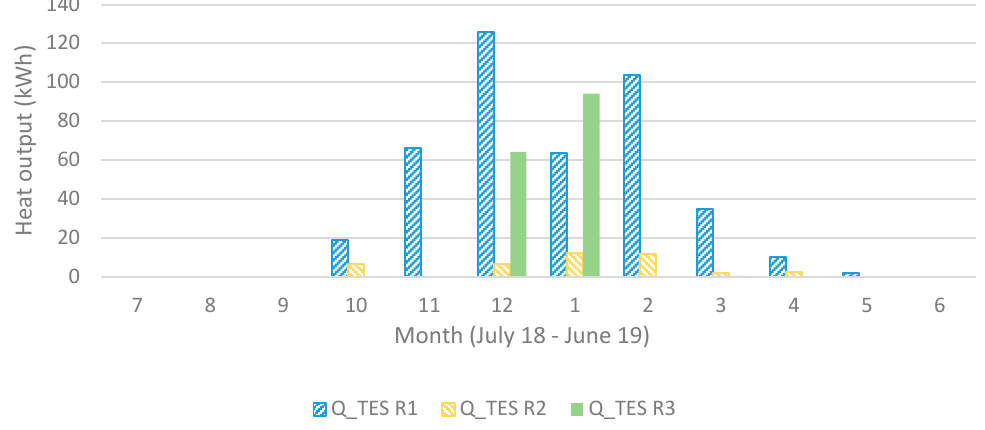
Figure 11. Heat output (in Sim4) for each operating unit (1 to 3) for each month.